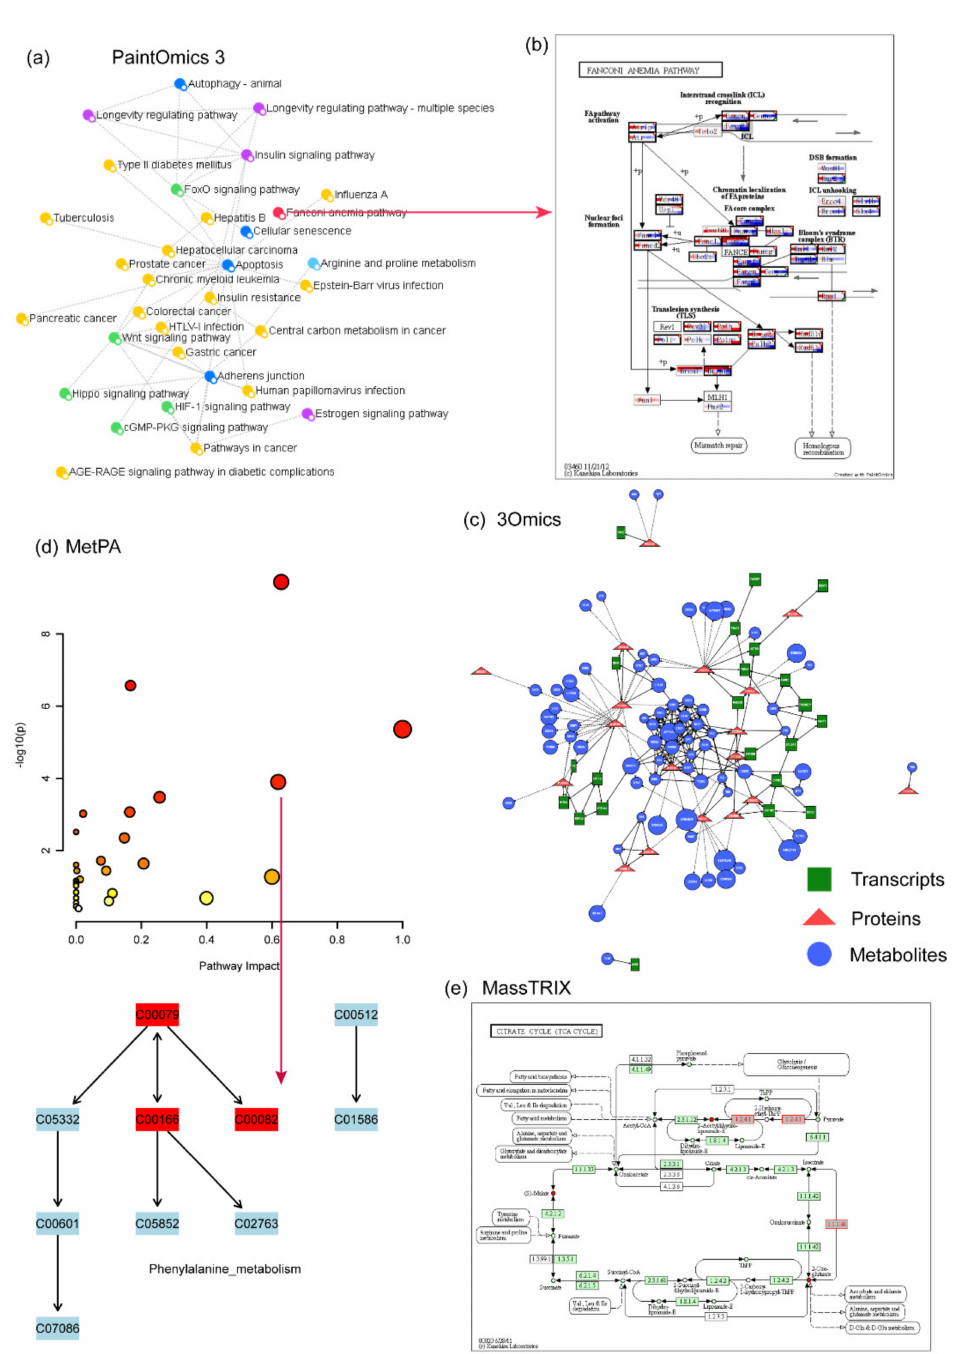
Figure 3. Example of other available metabolomics data analysis tools. ( a ) Pathway overview created by PaintOmics 3. By clicking on a circle, ( b ) the corresponding pathway view is generated, showing all genes involved in that pathway and their interactions. ( c ) A correlation network